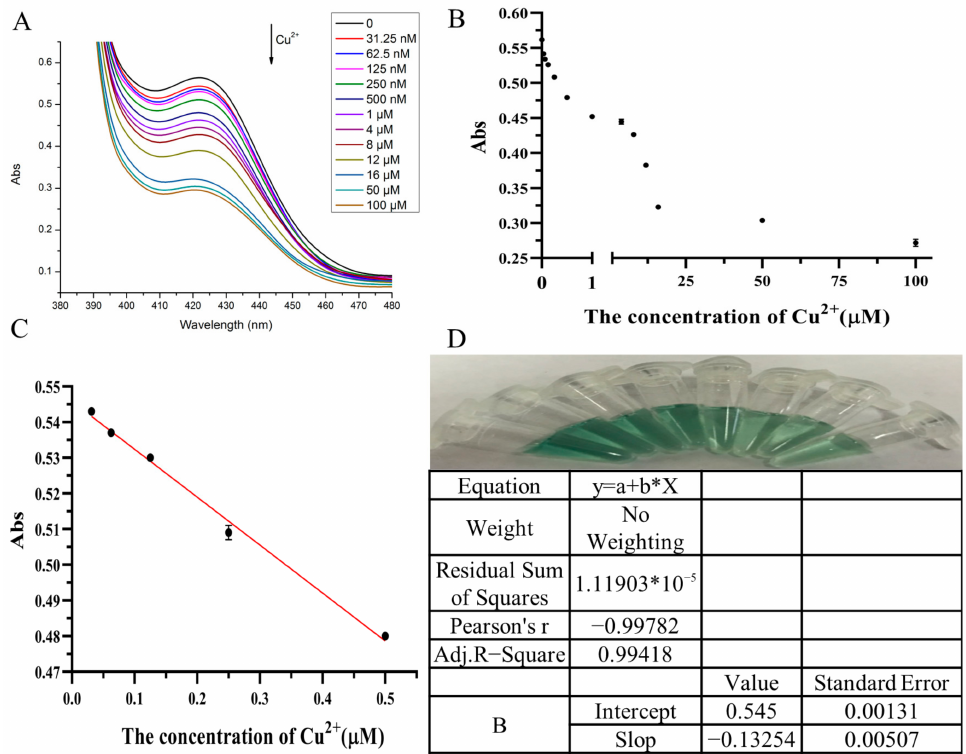
Figure 3. Sensitivity of the Cu 2+ sensor system. ( A ) UV-vis absorption spectra change under different Cu 2 + concentrations. The concentrations of Cu 2+ are: 0, 31.25 nM, 62.5 nM, 125 nM, 250 nM, 500 nM, 1 µ M, 4 µ M, 8 µ M, 12 µ M, 16 µ M, 50 µ M, and 100 µ M. ( B ) Absorbance ( λ = 419 nm) under different Cu 2 + concentrations. The concentrations of Cu 2+ are: 0, 31.25 nM, 62.5 nM, 125 nM, 250 nM, 500 nM, 1 µ M, 4 µ M, 8 µ M, 12 µ M, 16 µ M, 50 µ M, and 100 µ M. ( C ) The absorption signals of different Cu 2 + concentrations at λ = 419 nm. The inset shows that when the concentration of Cu 2 + is in the range of 31.25 ~ 500 nM, the concentration is linear with the color change. ( D ) The color of the detection results of different Cu 2 + concentrations and correlation measurement